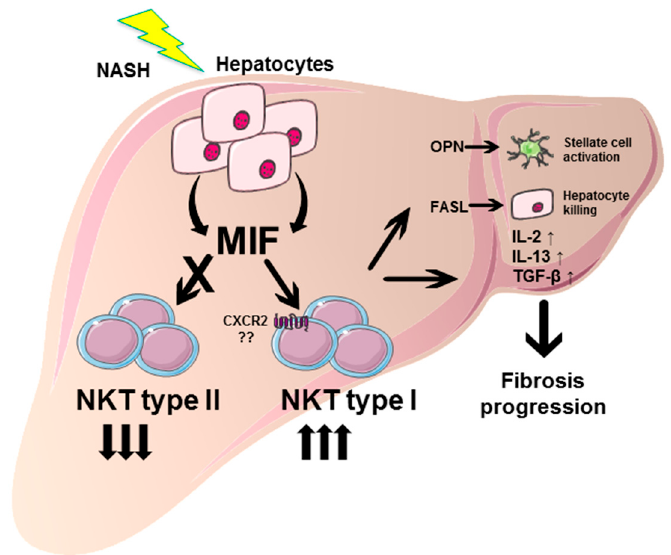
Figure 8. Graphical abstract summarizing the pro-fibrotic role of MIF in NASH and proposed underlying mechanisms. During NASH pathogenesis, MIF expression is strongly induced in hepatocytes. These increased intrahepatic MIF levels promote the differentiation of type I intrahepatic NKT cells, while differentiation towards type II NKT subpopulation is inhibited. Type I NKT cells exert pro-fibrotic properties, e.g., by secretion of OPN, activating hepatic stellate cells and consecutive collagen synthesis. Moreover, type I NKT cells perpetuate liver damage by FASL-mediated direct killing of hepatocytes, and orchestrate a pro-inflammatory and pro-fibrotic environment by expression of cytokines, e.g., IL-2, IL- 13 and TGF- β resulting in progression of hepatic fibrosis in NASH. This figure was created using Servier Medical Art templates, which are licensed under a Creative Commons Attribution 3.0 Unported License; https://smart.servier.com.